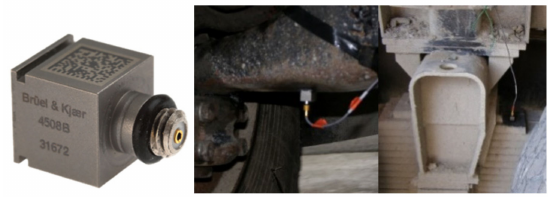
Figure 12. Sensor and its location on the front and rear axles.